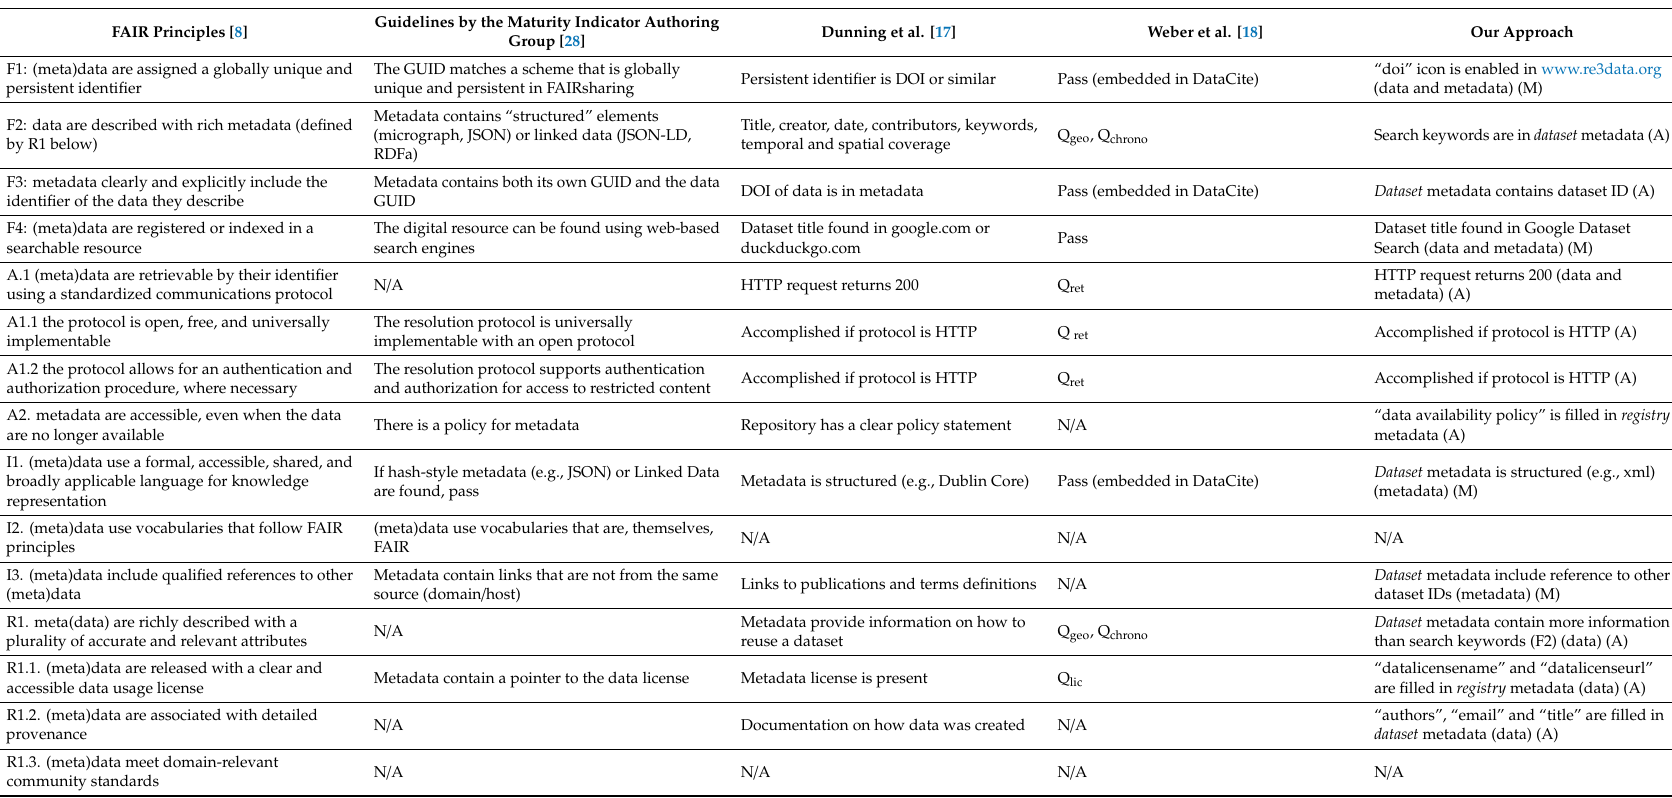
Table 2. FAIR principles and corresponding evaluation criteria proposed by the Maturity Indicator Authoring Group [28], Dunning et al. [17], Weber et al. [18], and our approach. The criteria used in the first two works are extracted from their publication text, whereas the criteria of Weber et al. are from Table IV of their paper. The metrics Weber et al. developed are Q geo for image location, Q time for the time of picture acquisition, Q ret when data is automatically downloadable only given its metadata, and Q lic for found license. In our approach, dataset metadata refers to metadata retrieved from the six databases used in our use cases, whereas registry metadata consists of metadata retrieved from re3data.org. In addition, we specify use of (meta)data as (data), (metadata), or (data and metadata), and automatic (A)